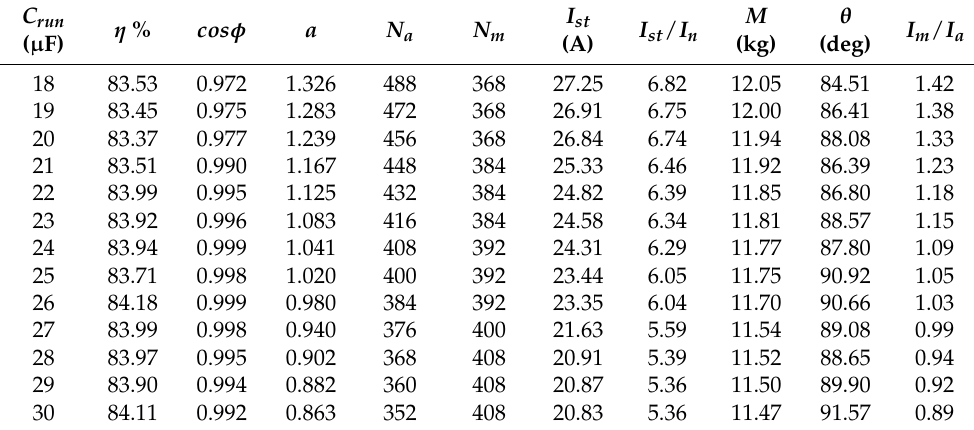
Table 4. Design parameters and performance quantities of the SPIMs with rotor bars of oval shape.